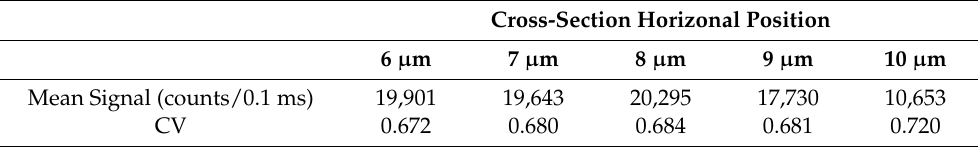
Figure 16. Excitation regions and signal distributions of simulated hydrodynamically-focused cross-sections shifted horizontally from the channel center (x = 6 µm). Compare to the cross-section centered at x = 6 µm shown in Figure 10a. ( a ) x = 7 µm; ( b ) x = 8 µm; ( c ) x = 9 µm; ( d ) x = 10 µm. Table 5. Results of hydrodynamically-focused cross-section horizontal position